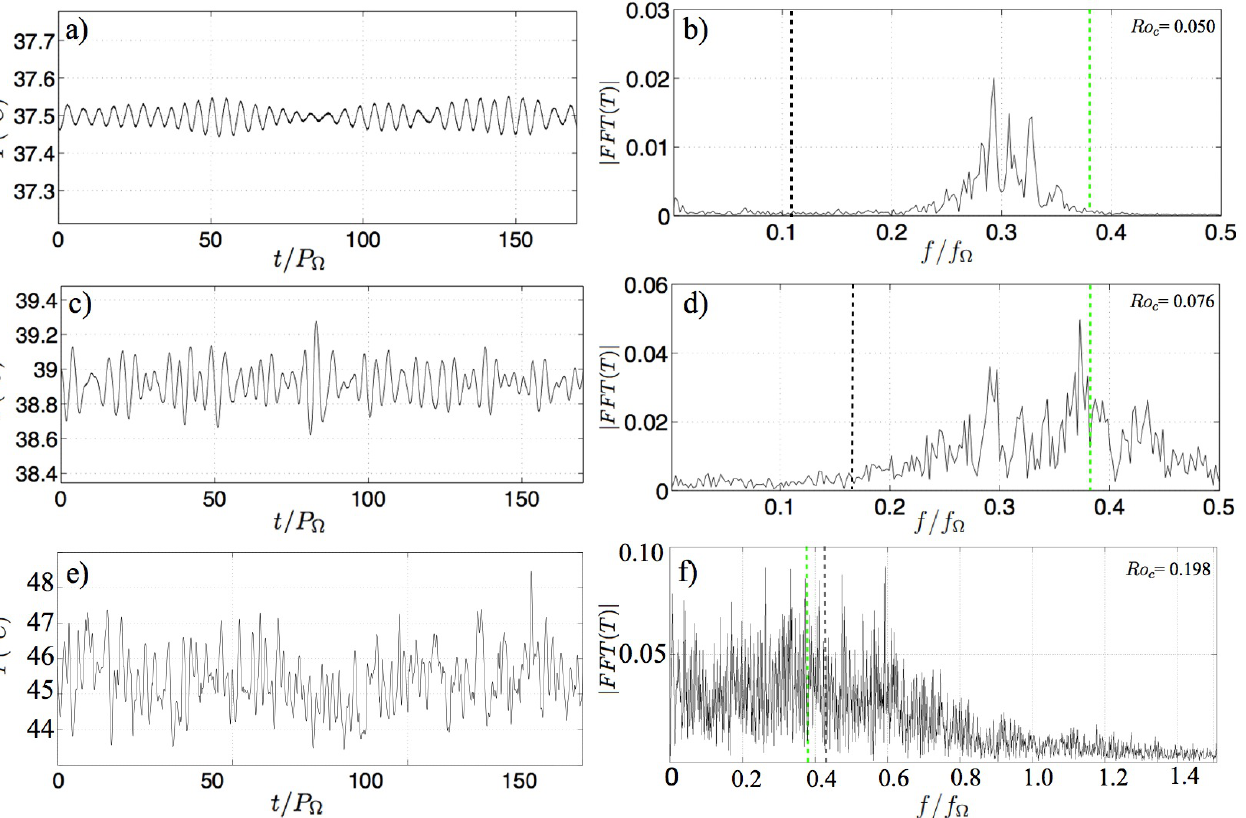
Figure 18. Thermistor T temperature time series (left column) and corresponding Fourier 3 spectra (right column) from the Γ = 1 . 87 , E = 2 × 10 − 5 RC laboratory cases ( a , b ) RC 1 ( c , d ) RC 2 ; and ( e , f ) RC 3 . Time is reported in rotation periods, P l l Frequency is normalized by the rotation frequency f dashed black lines denote each case’s normalized LSC frequency, f vertical dashed green lines denote the normalized onset frequency, f O /f convection with no-slip boundaries